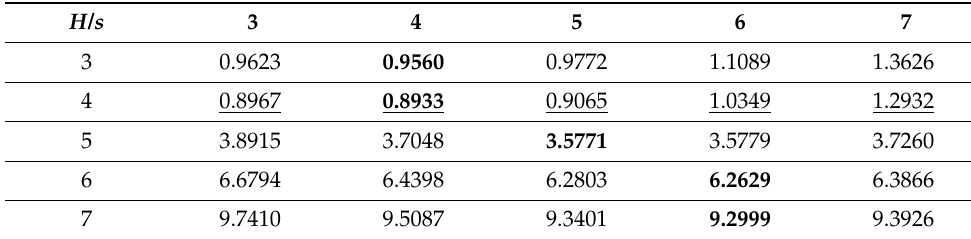
Table 2. Total expected cost rate interms of s and H .